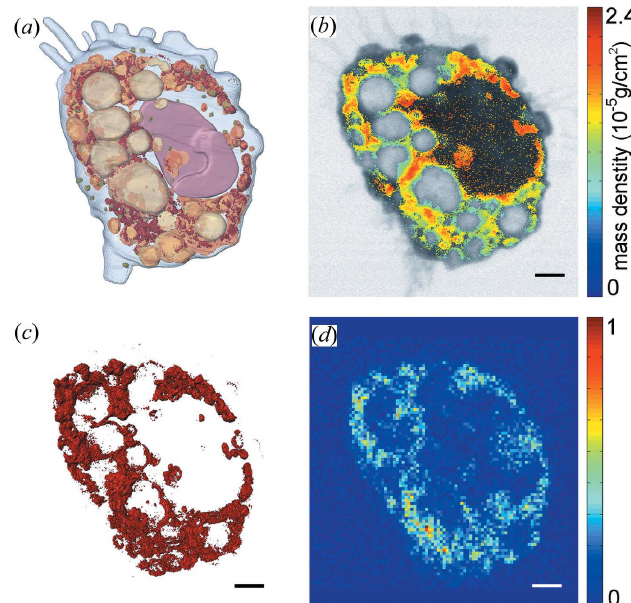
Figure 1 Multi-model imaging of the interaction of nanoparticles with a mammalian cell. ( a ) Three-dimensional image of a macrophage incubated and treated with Gd@C 82 (OH) 22 nanoparticles, showing the nucleus (brown), various lysosomes (yellow) and the nanoparticle (dark red). The image was obtained by combining dual-energy X-ray microscopy with an advanced three-dimensional reconstruction algorithm, termed equal slope tomography (EST). ( b ) Distribution of the nanoparticles in a two-dimensional projection of the macrophage. ( c ) Three-dimensional intracellular distribution of the nanomaterials. ( d ) X-ray fluorescence microscopy image of the macrophage. The scale bar corresponds to 2.0 m